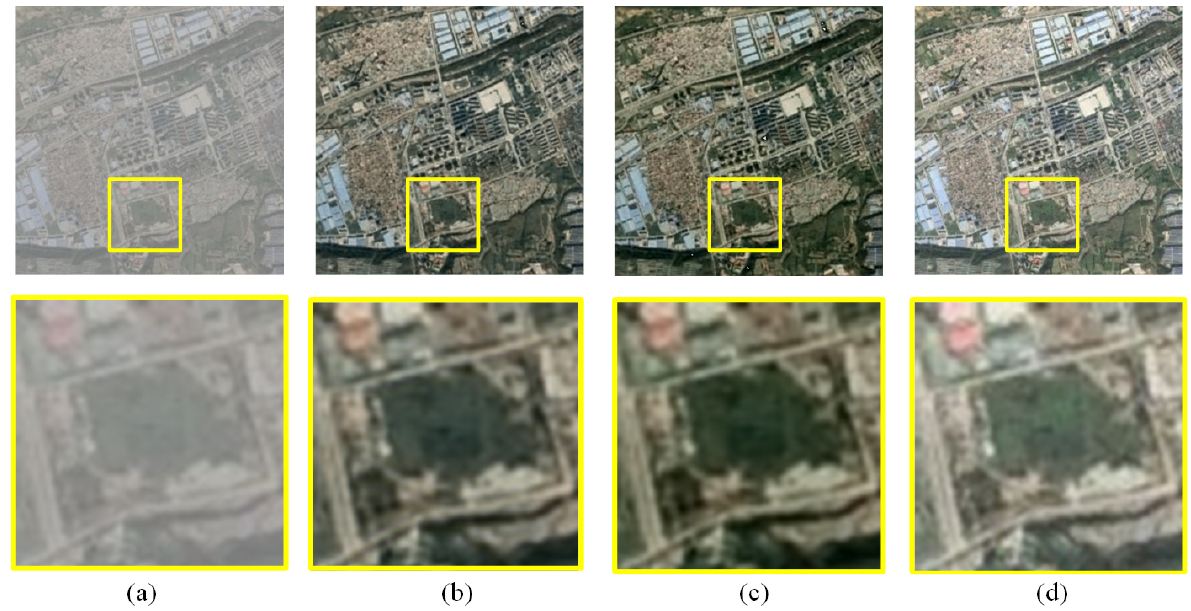
Figure 9. The thin cloud removal results of a RICE1 sample reconstructed with different fidelity losses: ( a ) input cloudy image, ( b ) reconstructed image with the (cid:96) 2 loss, ( c ) reconstructed image with the (cid:96) 1 loss, and ( d ) reference cloud-free image.